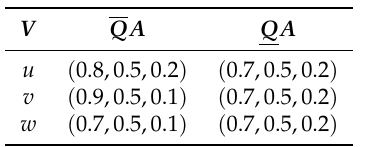
Table 9. Neutrosophic soft rough set on V .